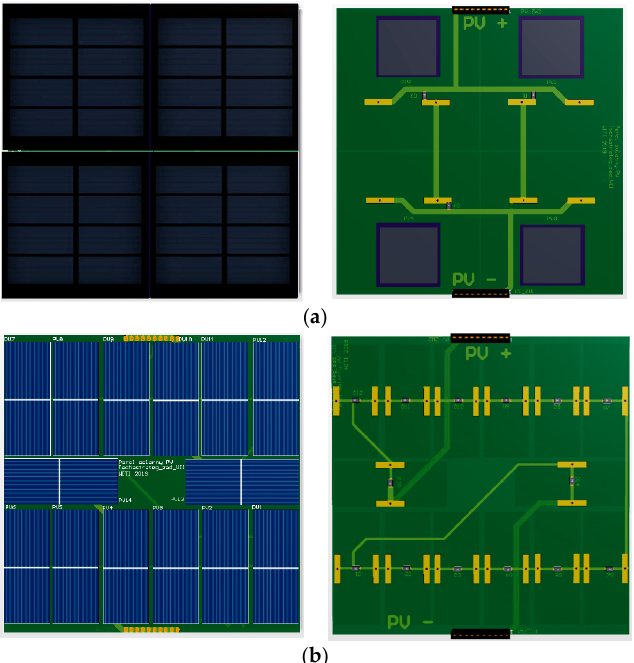
Figure 4. Visualization of printed electric board with photovoltaic elements. ( a ) PV system in parallel–series connection, ( b ) series connection of 14 PV elements in top view (left side) and bottom view (right side).